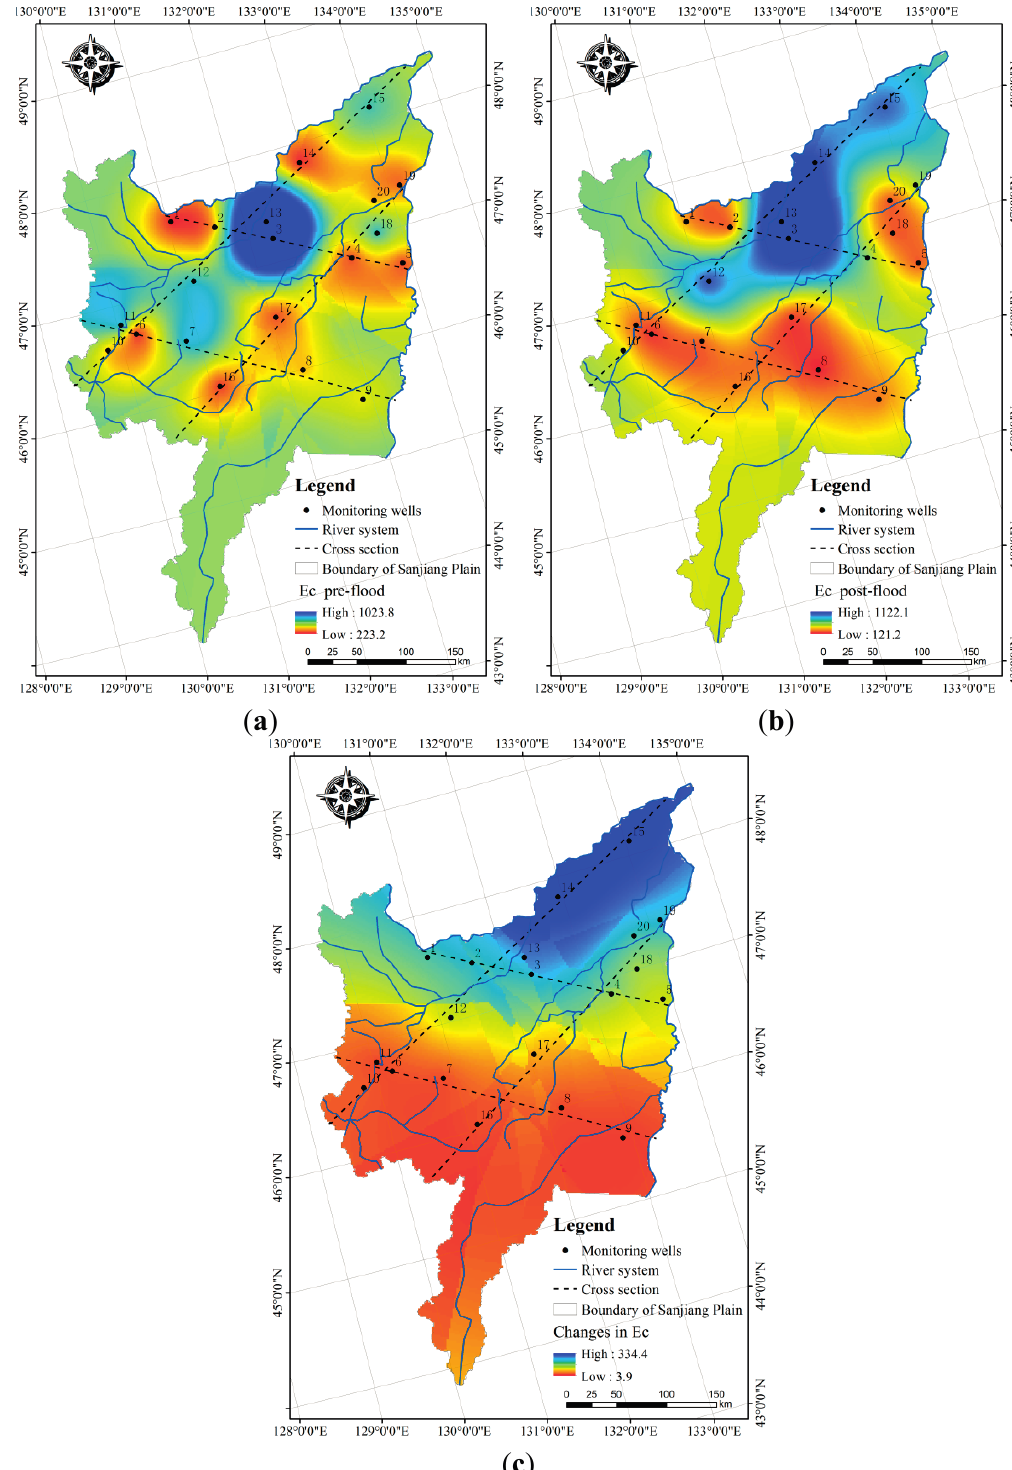
Figure 8. Changes in shallow groundwater EC following the 2013 summer flood in the Sanjiang Plain, Northeast China: ( a ) pre-flood; ( b ) post-flood; and ( c ) changes between pre- and